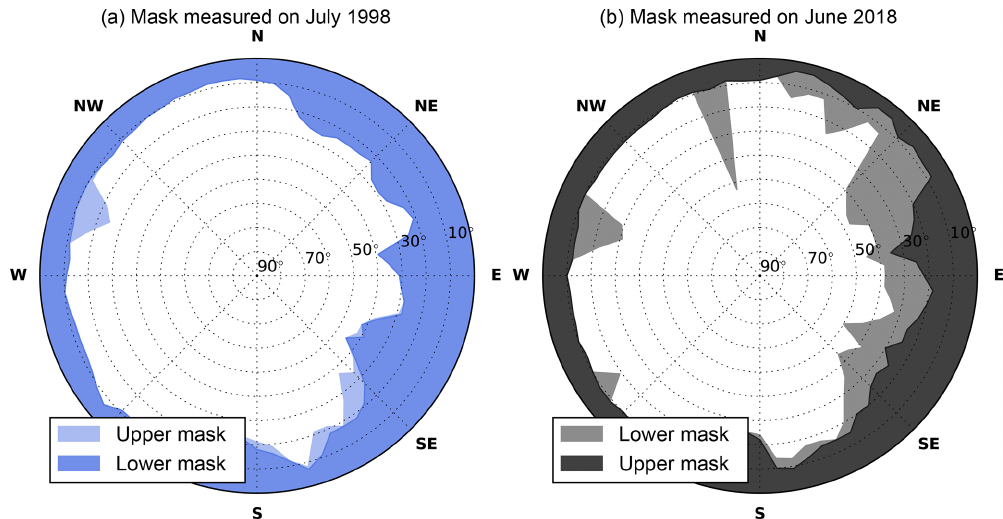
Figure 3. Masks measured at location 31 (Fig. 2) on July 1998 (a) and on June 2018 (b) . Upper and lower mask elevations are represented by the coloured areas. Elevations are given in degrees, the centre is 60 ◦ elevation.